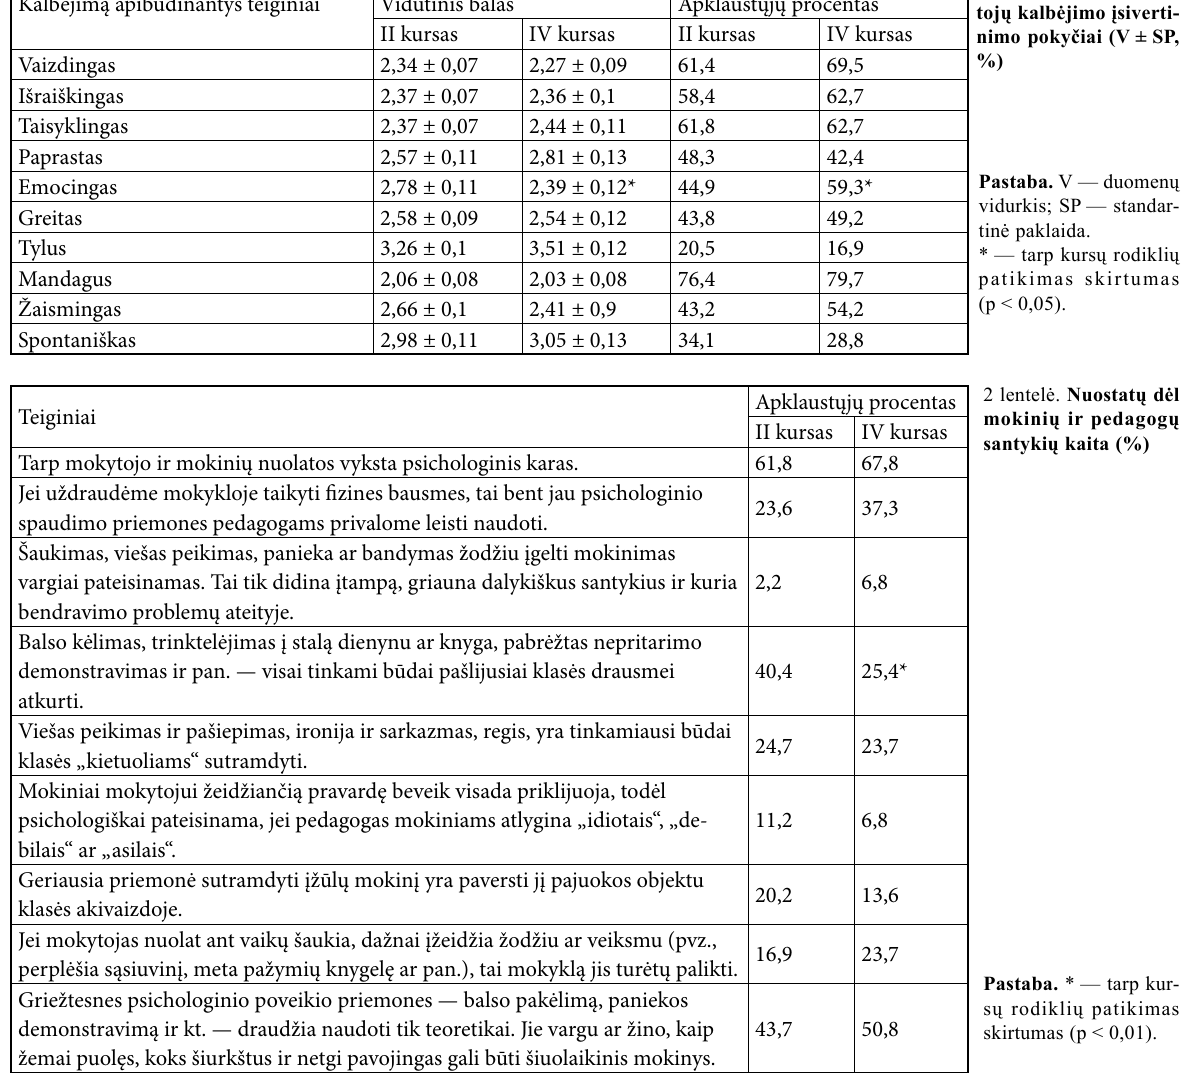
Pastaba. * — tarp kur- s ų rodikli ų patikimas skirtumas (p <